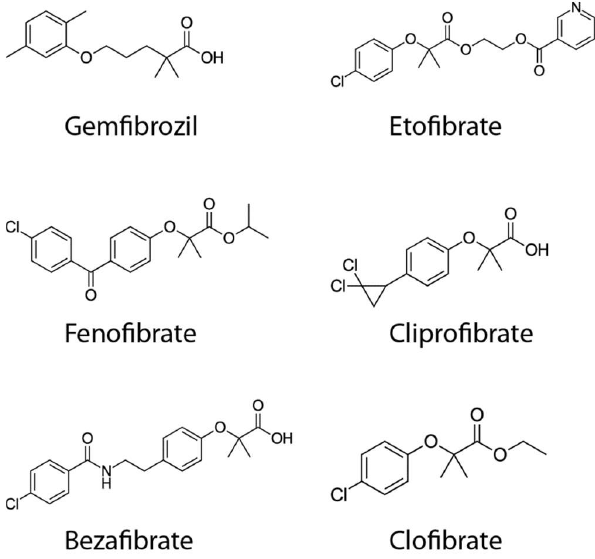
Figure 3. Chemical structures of fibrates.